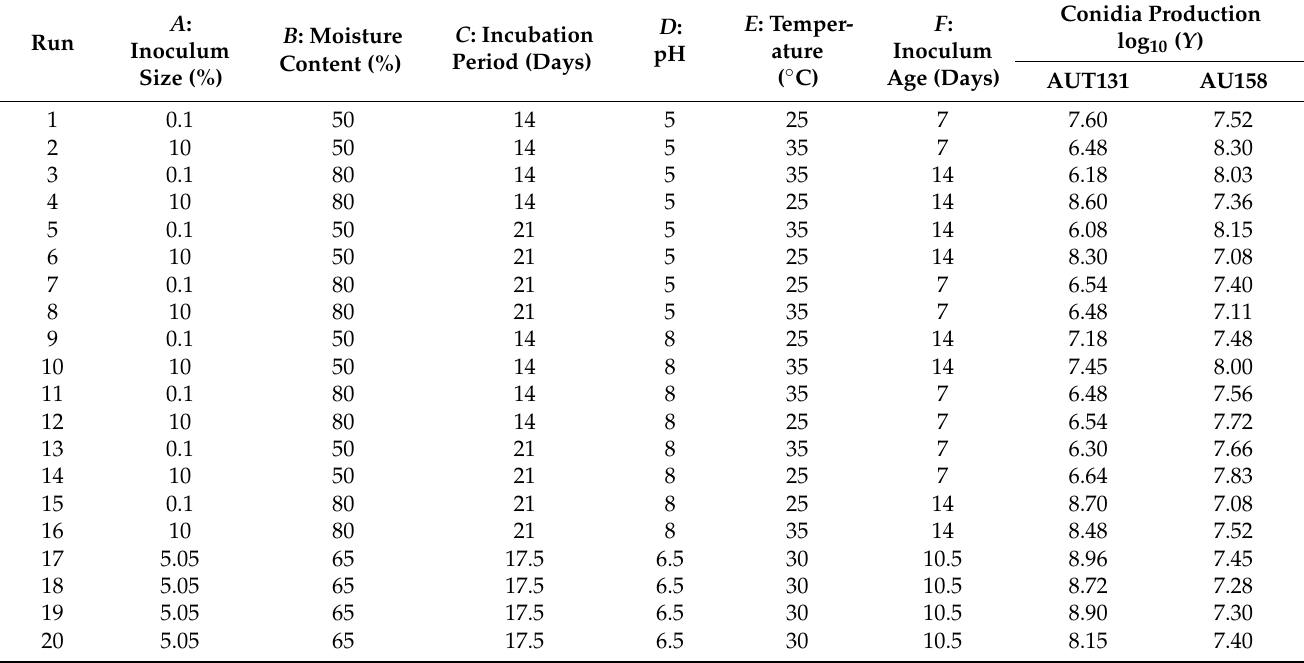
Table 2. Two-level FFD matrix for screening significant variables for Trichoderma species conidia